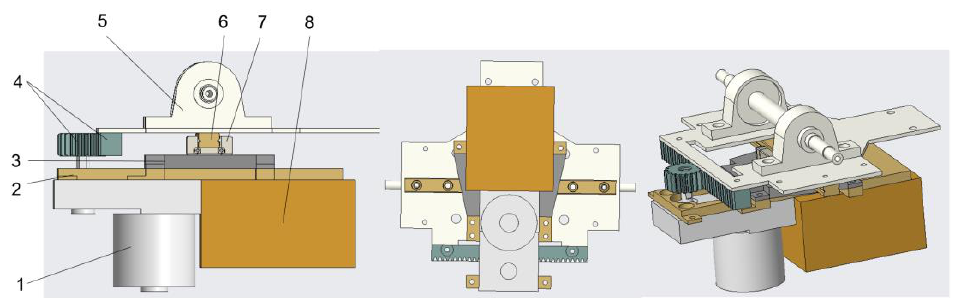
Figure 4. Structure diagram of the steering module. 1-steering motor, 2-steering sheet metal 1, 3-steering sheet metal 2, 4-gear-rack drive, 5-major shaft, 6-slide rail, 7-slider, and 8-battery pack.